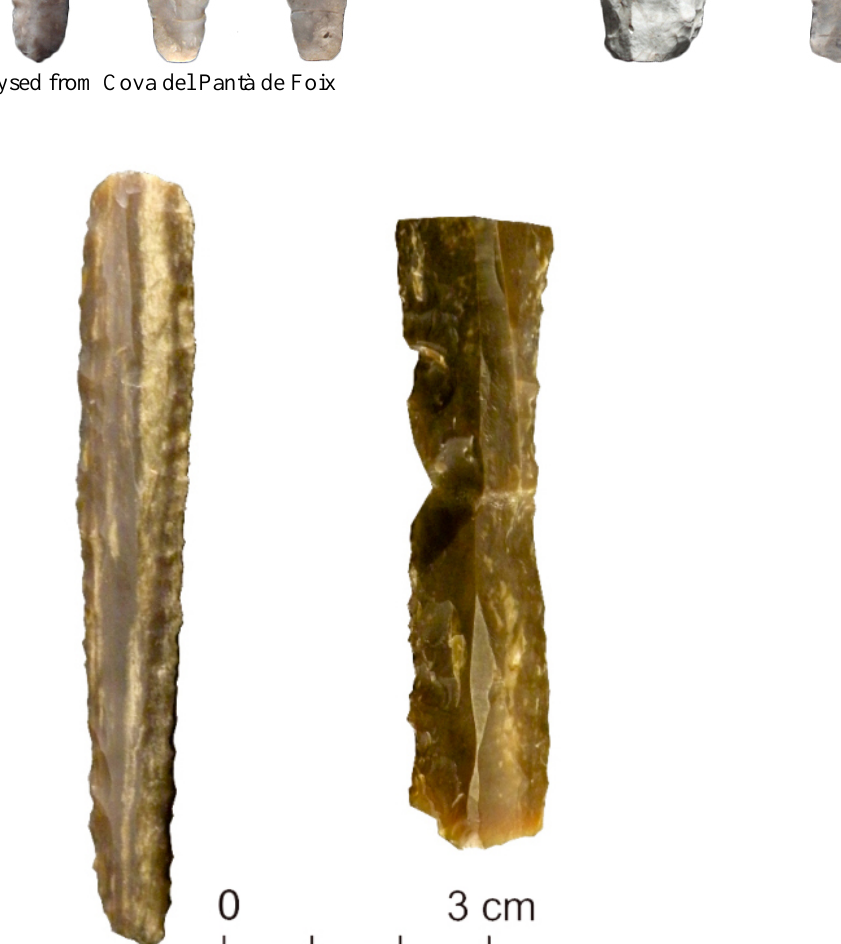
Figure 6. Two Fortcalquier large blades from Cova de la Font del